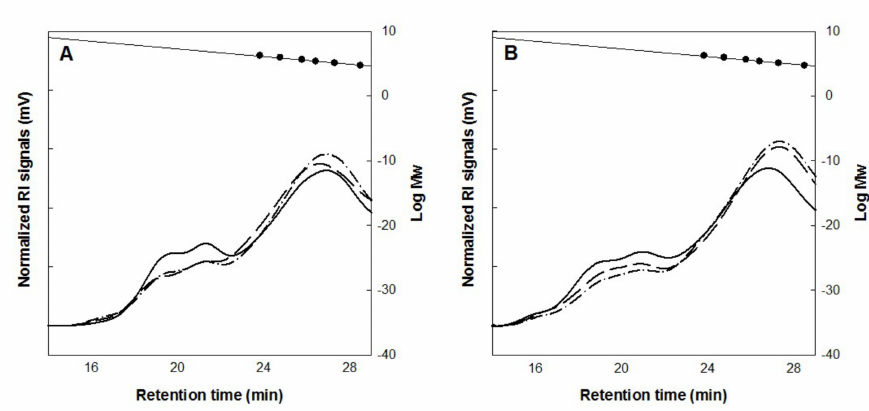
Figure 2. High-performancesize-exclusionchromatography(HPSEC)analysisofwater-solublearabinoxylan (WS-AX) extracted from fresh and frozen bread doughs. Fresh ( A ) and frozen bread dough ( B ) formulated with Exyl. After mixing, ——; after proofing, ——; after baking, – · – · –. Molecular size makers spotted inside the chromatogram from the left to the right are 1600, 788, 400, 212, 112, and 47.3